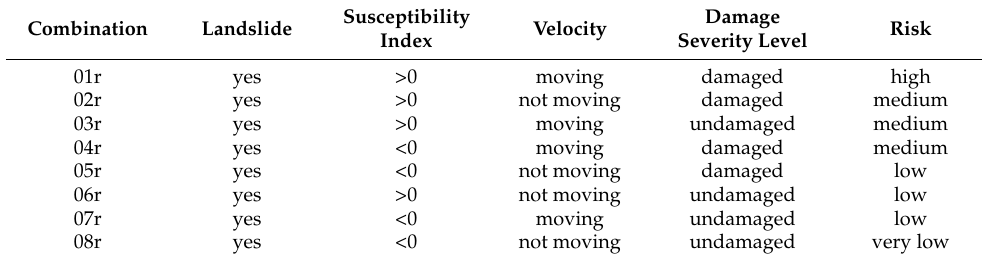
Table 1. Correlation matrix defining the different levels of risk.